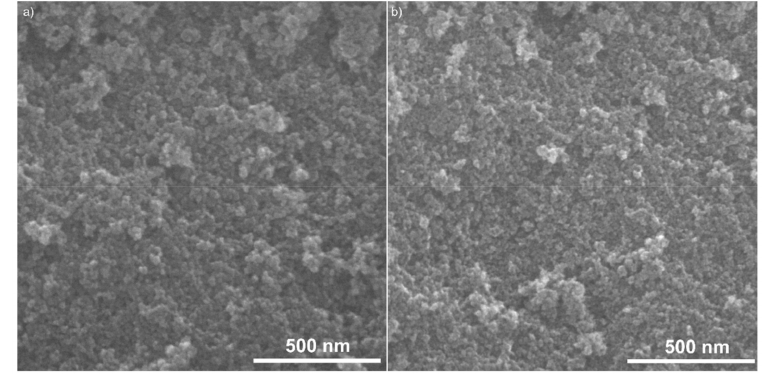
Figure 6. SEM images of the HApAg20 ( a ) and HApAg5 ( b ) composite layers.